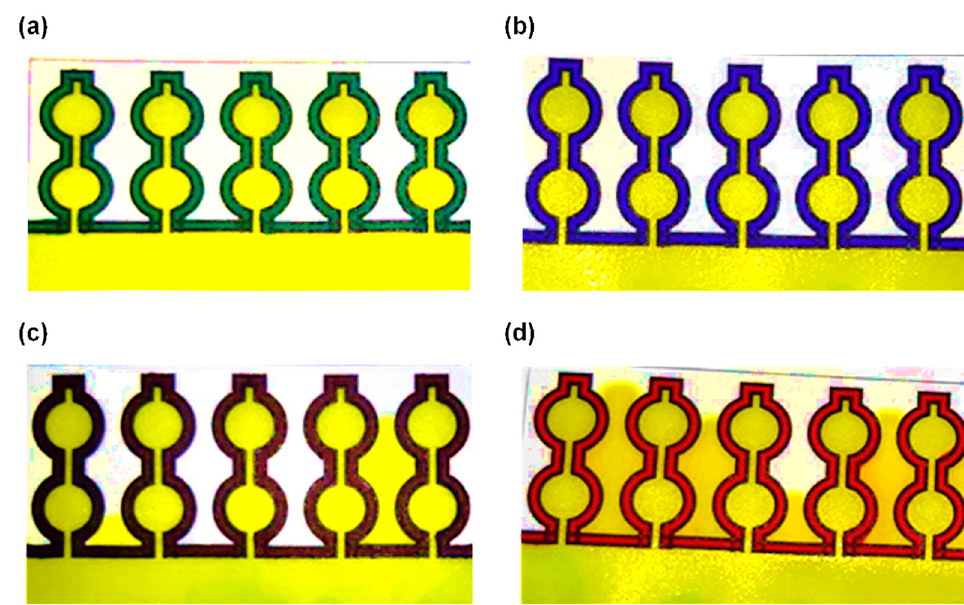
Figure 4. Leakage analysis for different marker colors on the device: ( a ) green marker, ( b ) blue marker, ( c ) black marker, ( d ) red marker.